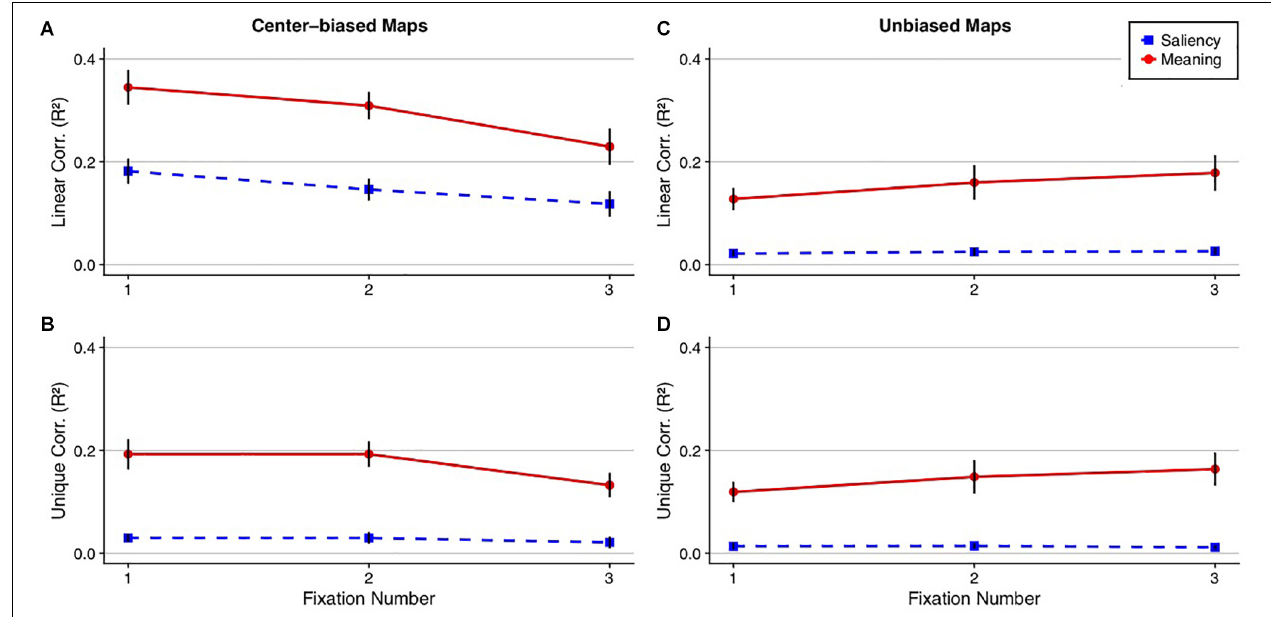
FIGURE 6 | Ordinal fixation analysis comparing meaning and image salience. The line plots show (A,C) the squared linear and (B,D) semi-partial correlations between the fixation density maps, meaning (red circle), and image salience (blue square) as a function of fixation number collapsed across scenes using the (A,B) center-biased and (C,D) unbiased prediction maps. Error bars represent the standard error of the